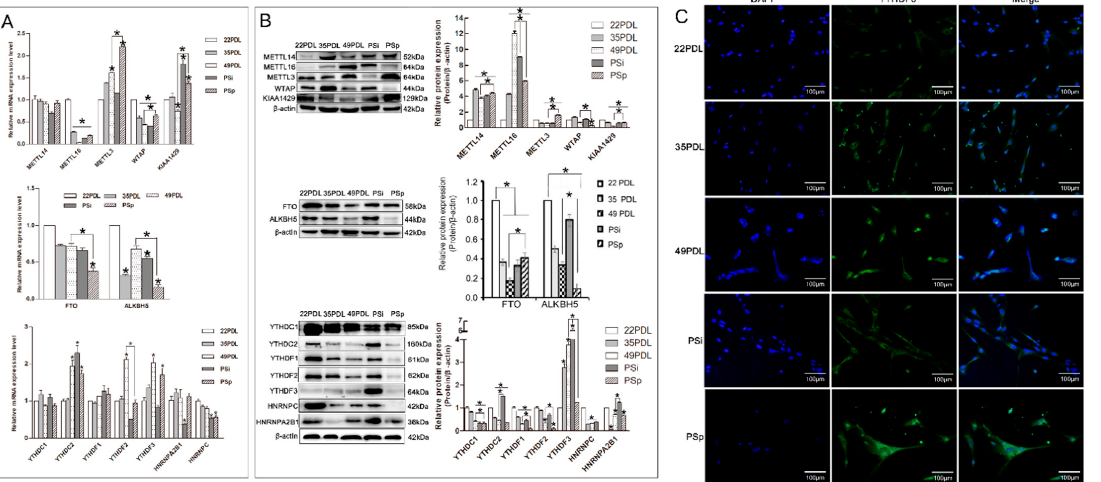
Figure 3. Expression of enzymes associated with m6A modification. ( A ) The relative mRNA expres- sion of RNA methyltransferase, demethylase, and binding proteins. The 22PDL group was set as 1 and the values of the other groups were relative to the 22PDL group. ( B ) Western blotting analysis for RNA methyltransferases, demethylases, and binding proteins and their quantifications. ( C ) The immunofluorescence images of YTHDF3 under the fluorescence microscope (200×, 100 μ m). The green represented immunofluorescence stained by the YTHDF3. Nuclei were counterstained with DAPI as blue. The data are presented as the mean ± SEM ( n = 3). Compared with the 22PDL or 49PDL group, * p < 0.05.